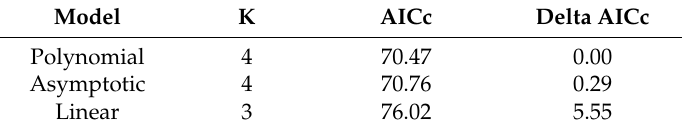
Table 2. Model selection for overall flammability (PCA 1)